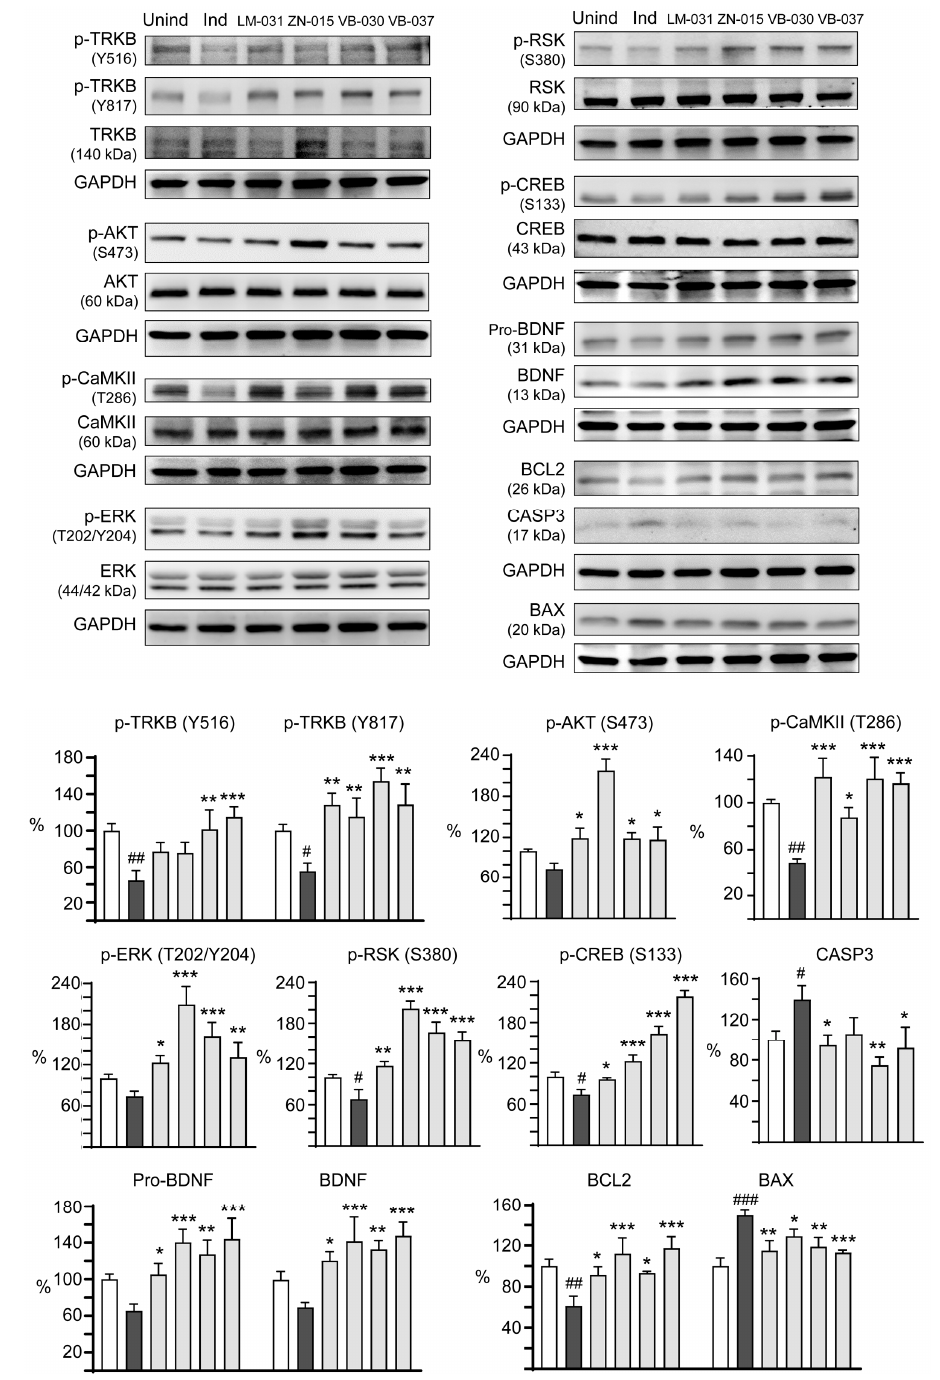
Figure 5. Activation of TRKB signaling in ∆ K280 Tau RD -DsRed SH-SY5Y cells. p-TRKB (Y516 and Y817), TRKB, p-AKT (S473), AKT, p-CaMKII (T286), CaMKII, p-ERK (T202/Y204), ERK, p-RSK (S380), RSK, p-CREB (S133), CREB, BDNF (pro- and mature), BCL2, BAX and CASP3 levels analysed by immunoblotting using GAPDH as a loading control ( n = 3). To normalize, the protein expression level in uninduced cells was set at 100%. p values: comparisons between induced vs. uninduced cells ( # : p < 0.05, ## : p < 0.01, ### : p < 0.001), or compound-treated vs. untreated cells (*: p < 0.05, **: p < 0.01, ***: p < 0.001) (one-way ANOVA with a post hoc Tukey test).